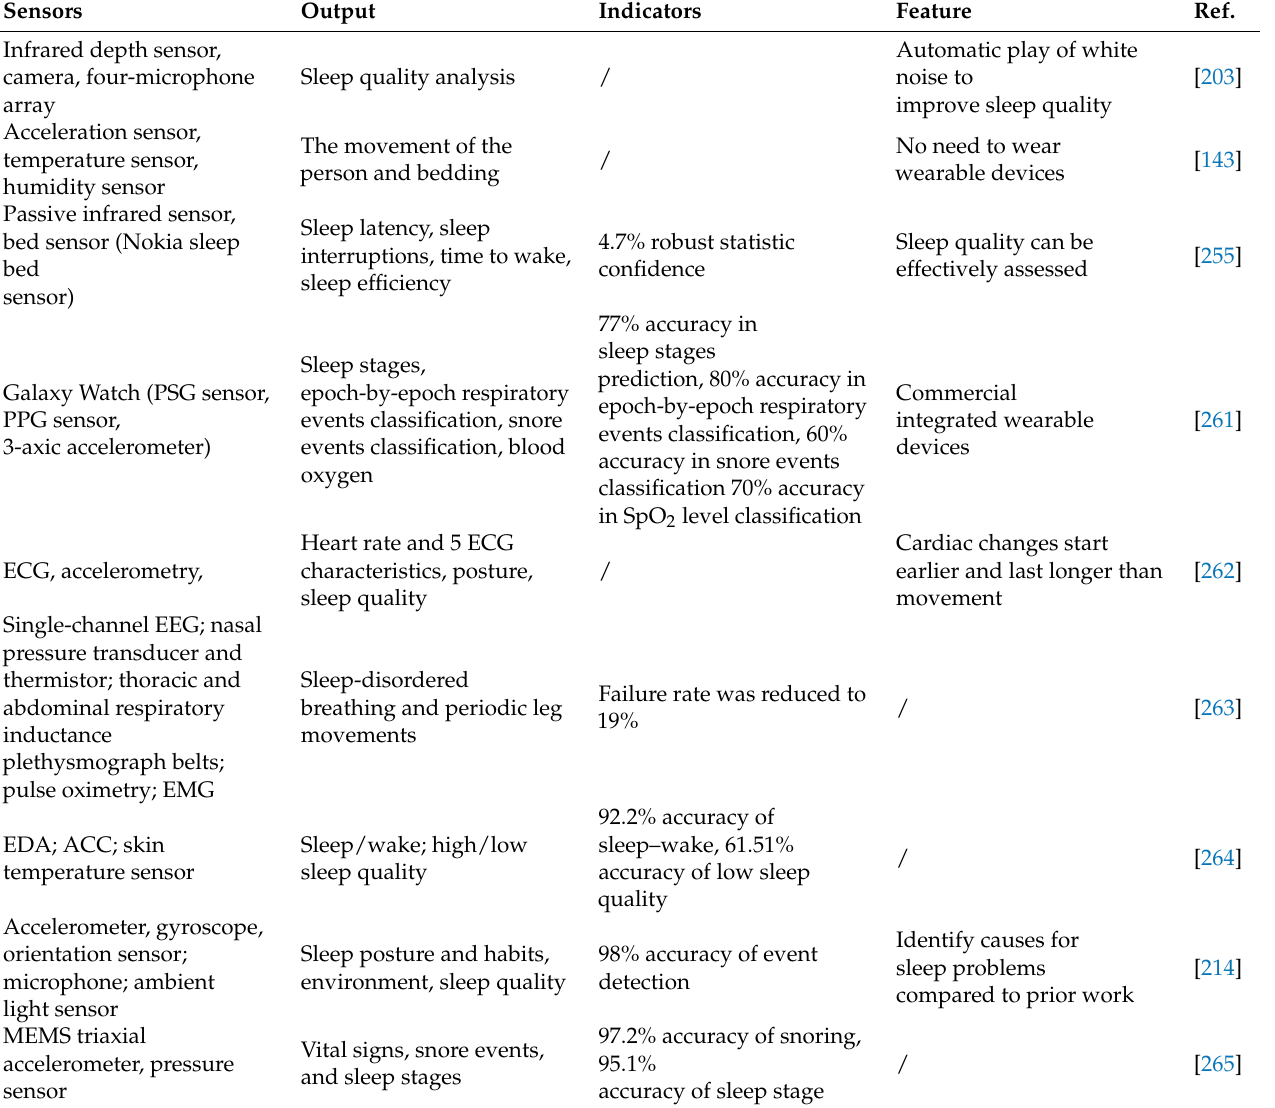
Table 5. Table of integrated sleep